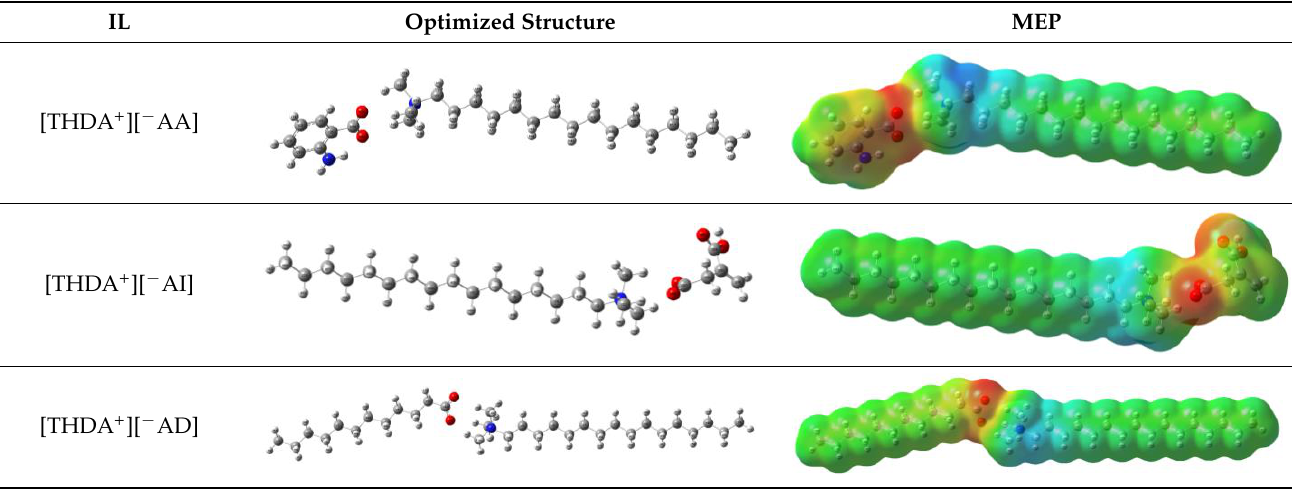
Table 5. Optimized structures and molecular-electrostatic-potential (MEP) mapping of the ILs obtained at B3LYP/6-311G level in aqueous medium.